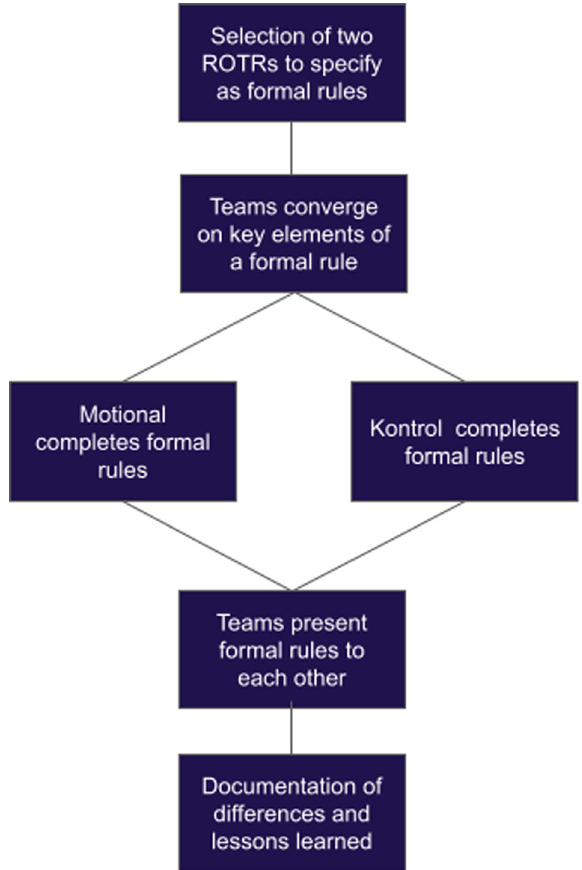
Fig. 1 The study setup. A description of how Motional and Kontrol conducted the traf fi c law